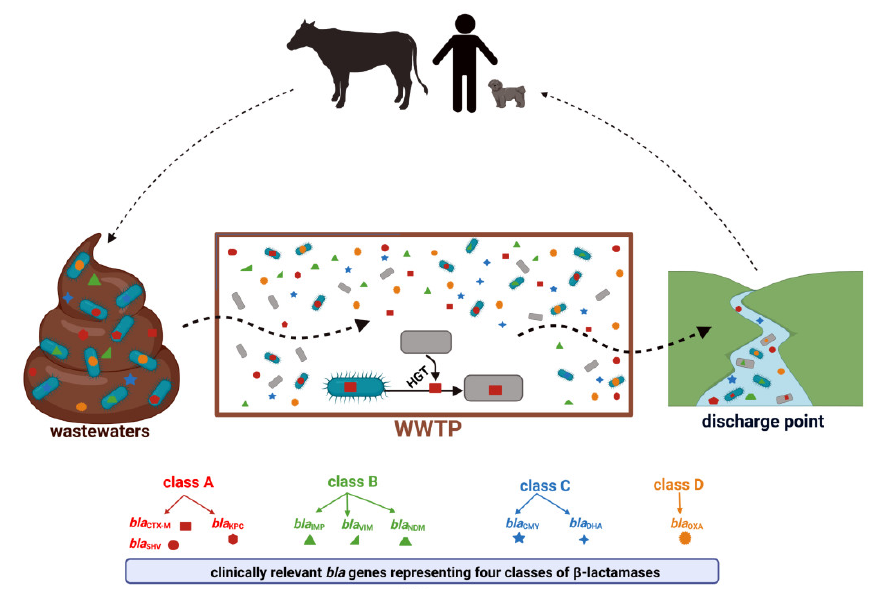
Figure 3. WWTP as a hotspot for the transmission of clinically relevant β-lactam resistance genes, created with BioRender available online: https://biorender.com, accessed on 23 May 2022). Descriptions of the enzymes included in the Figure 3 can be found in Sections 4.1–4.4.